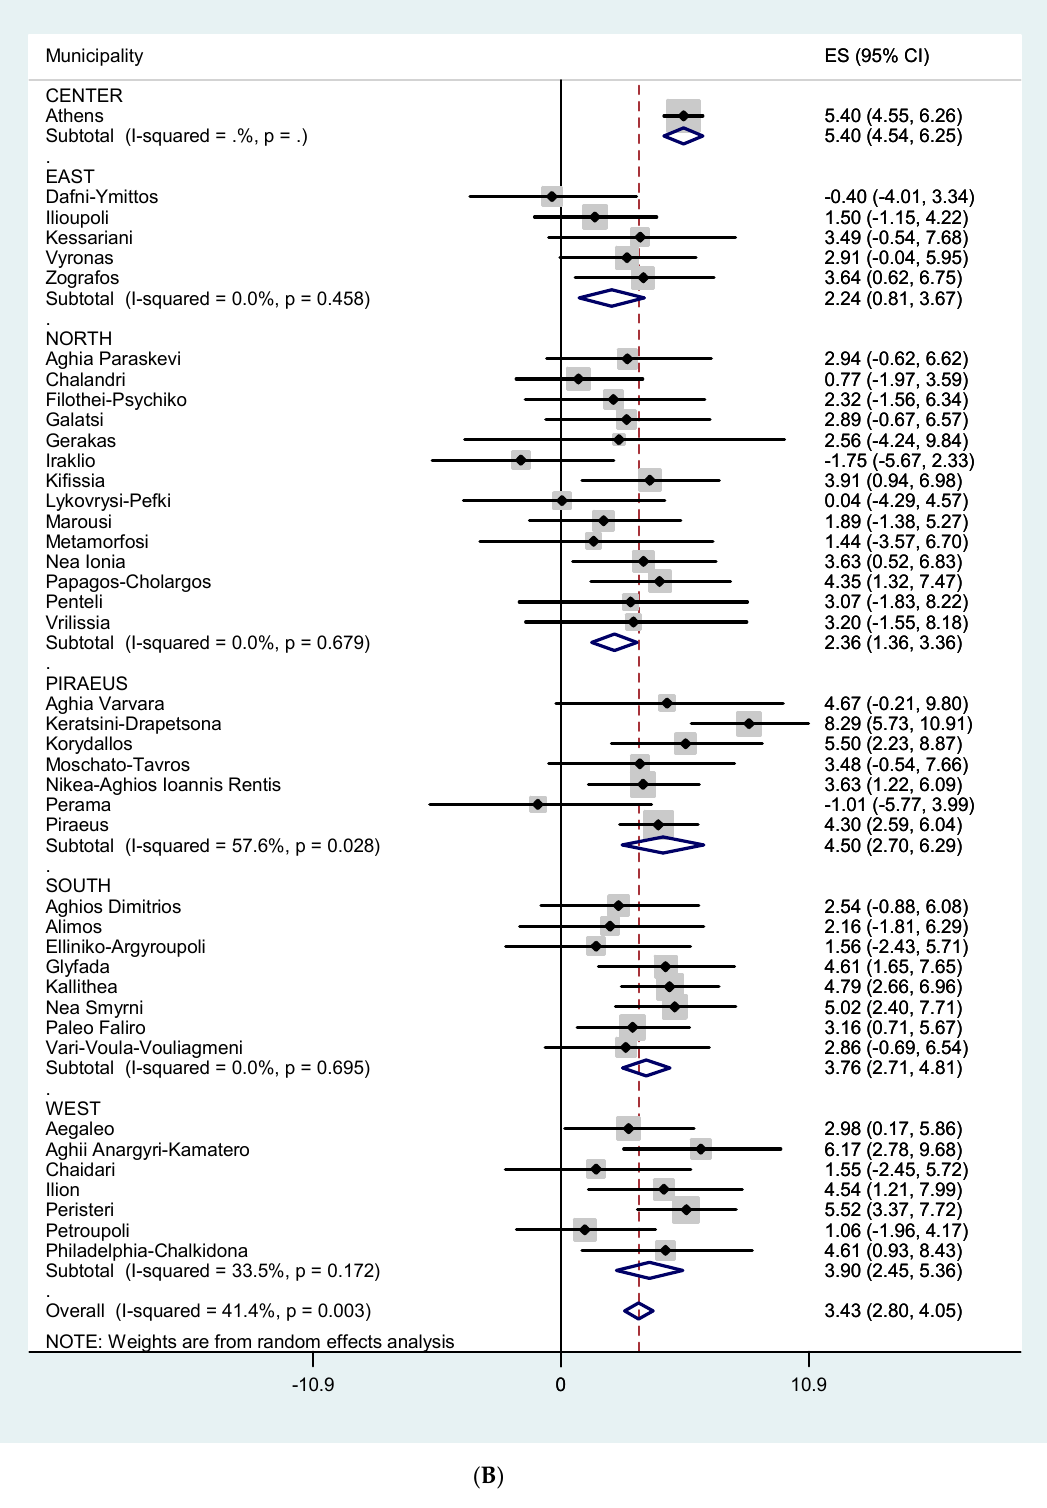
Figure 3B. ( A ) % increase in total mortality, all ages, per 1 °C increase in maximum temperature in Figure 3. ( A ) % increase in total mortality, all ages, per 1 ◦ C increase in maximum temperature in each each municipality, using Thissio measurements and threshold of 31.5 °C. ( B ) % increase in total municipality, using Thissio measurements and threshold of 31.5 ◦ C. ( B ) % increase in total mortality mortality among the elderly (75+) per 1 °C increase in maximum temperature in each municipality, among the elderly (75 + ) per 1 ◦ C increase in maximum temperature in each municipality, using Thissio using Thissio measurements and threshold of 31.5 °C. measurements and threshold of 31.5 ◦